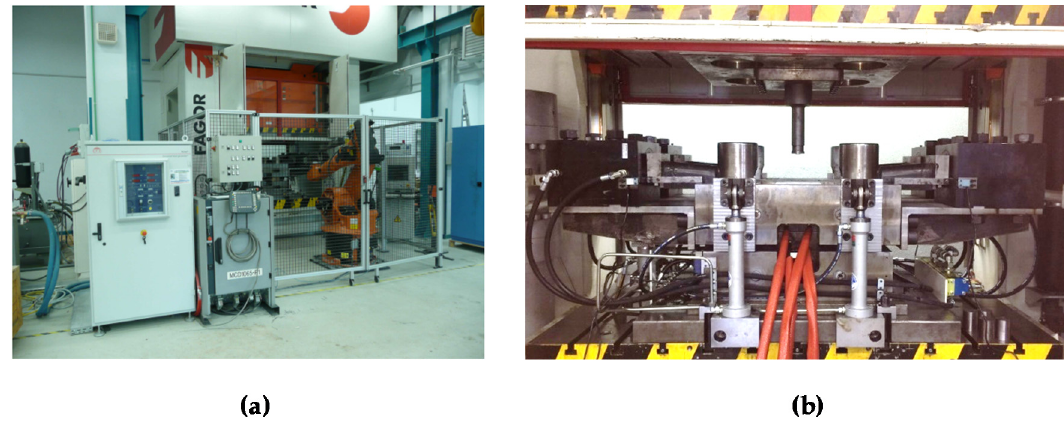
Figure 1. ( a ) The near solidus forming (NSF) cell of Mondragon Unibertsitatea (MU) and ( b ) the self-designed NSF tooling for high-melting-point alloys.